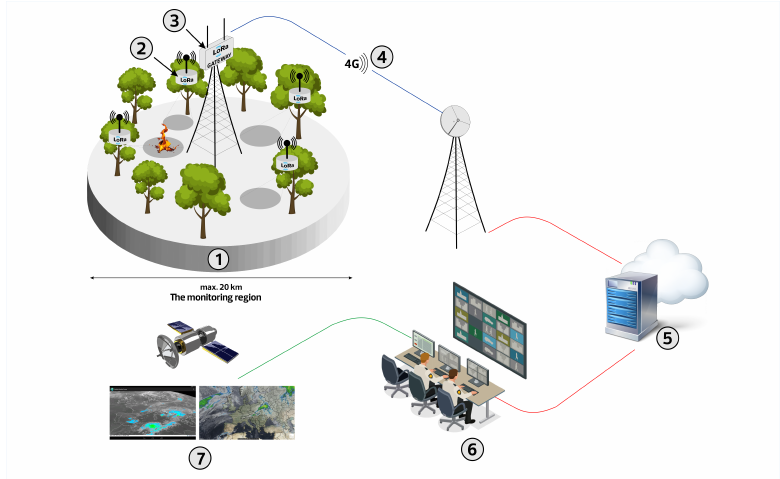
Figure 1. Illustration of Forest Alert Monitoring System (SAFe) system architecture